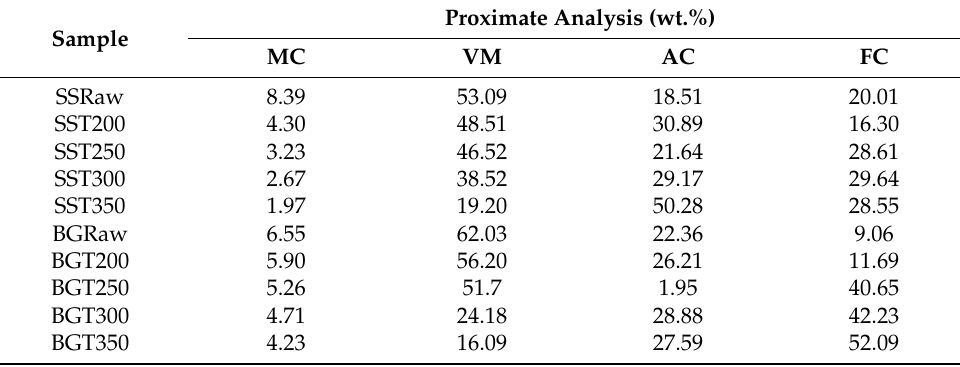
Table 1. Proximate analysis of raw and torrefied sewage sludge and sugarcane